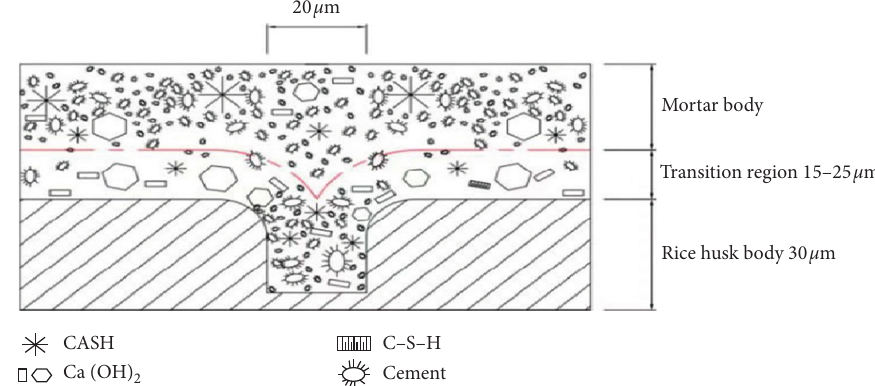
Figure 9: Interface area model with the holes in rice